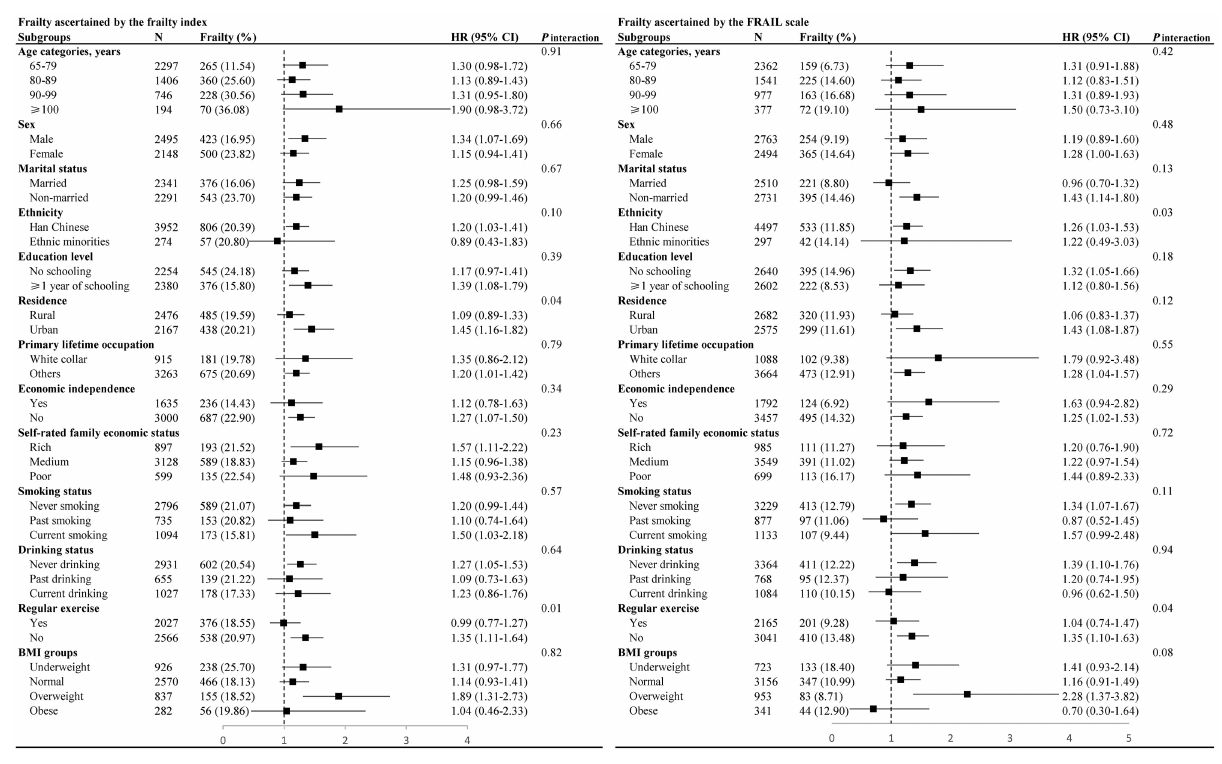
FIGURE2 Stratified analyses to identify variables that may modify the association between biomass fuels and frailty. Hazard ratios were adjusted for age, sex, marital status, ethnicity, education, residence, primary lifetime occupation, economic independence, self-rated family economic status, household annual income, smoking status, drinking status, regular exercise, and BMI, except for the stratified variable. BMI, body mass index; HR, hazard ratio; CI, confidence